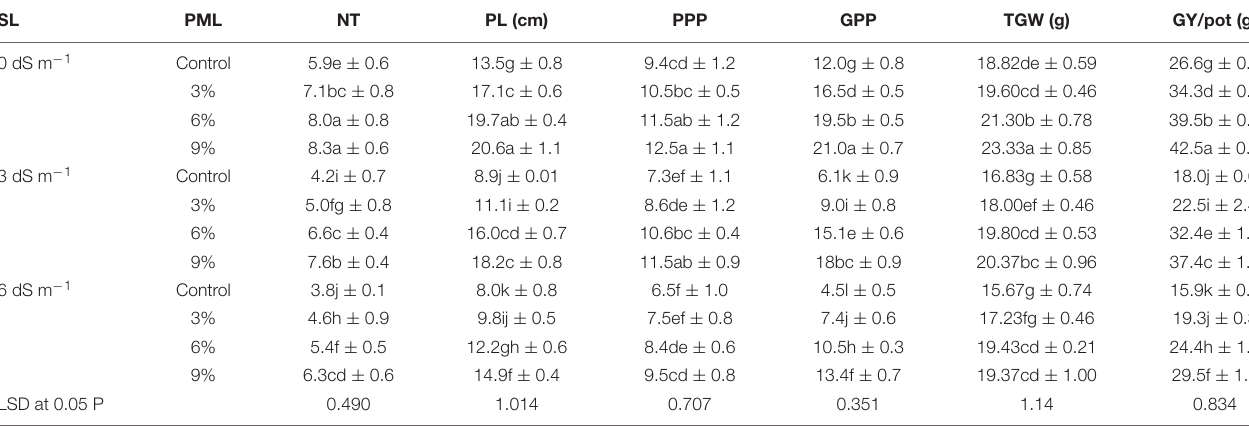
FIGURE 5 | Effect of different levels of press mud application on Na + (A) , and K + (B) contents of rice crop grown under varying levels of salinity stress. The bars indicate the means of three replications with ± S.E. and a different letter indicating significant differences at p < 0.05. TABLE 2 | Effect of different levels of press mud application on yield and yield attributes of rice plants grown under different levels of salinity stress. SL PML NT PL (cm) PPP GPP TGW (g) GY/pot